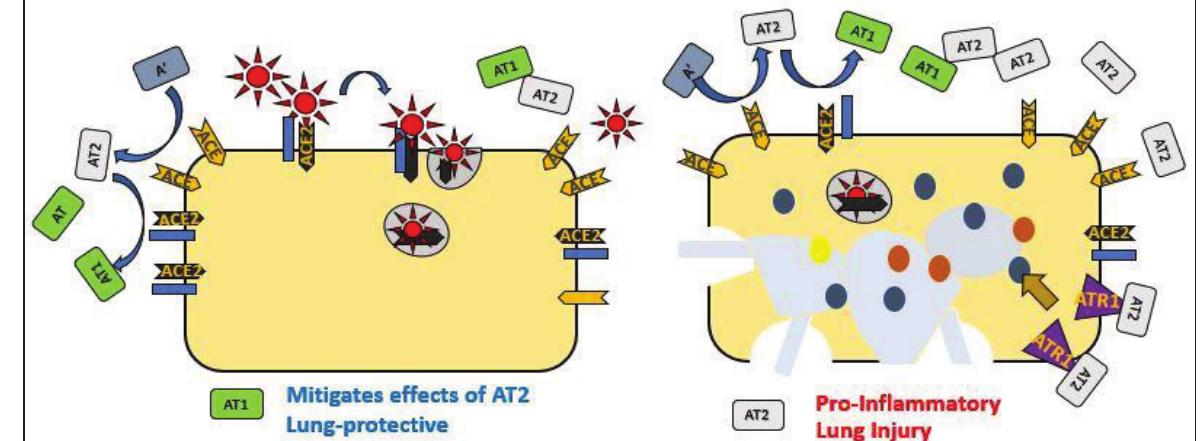
Fig-A: Hypothesized mechanism of SARS-CoV2 cell-infectivity and subsequent lung-damage with focus on the balance between ACE (yellow) and ACE2 (black). SARS-CoV2 (red spiked spheres) via its spike glycoprotein S bind with ACE2 on lung epithelial cells. S is cleaved to s1 and s2 (not shown) by TMPRSS (blue stripe) and internalized. This also leads to the internalization of ACE2 and thus decreased numbers of ACE2 on the epithelium. Decreased ACE2 and relative increased ACE disturbs the balance. This subsequently results in more AT2 compared to AT1 (as shown in the second part of the figure). AT2 binds its receptor ATR1 and can potentially contribute towards diffuse alveolar edema and inflammatory acute lung injury as shown by edema and infiltrates in the second part of the figure. Red spiked spheres = SARS-CoV2. Yellow chevron arrows = ACE. Black chevron arrows = ACE2. Blue strips = TMPRSS. Light blue box = Angiotensin 2 (AT2). Green box = Angiotensin 1-7 (AT1). Purple triangle = Angiotensin 2 Receptor